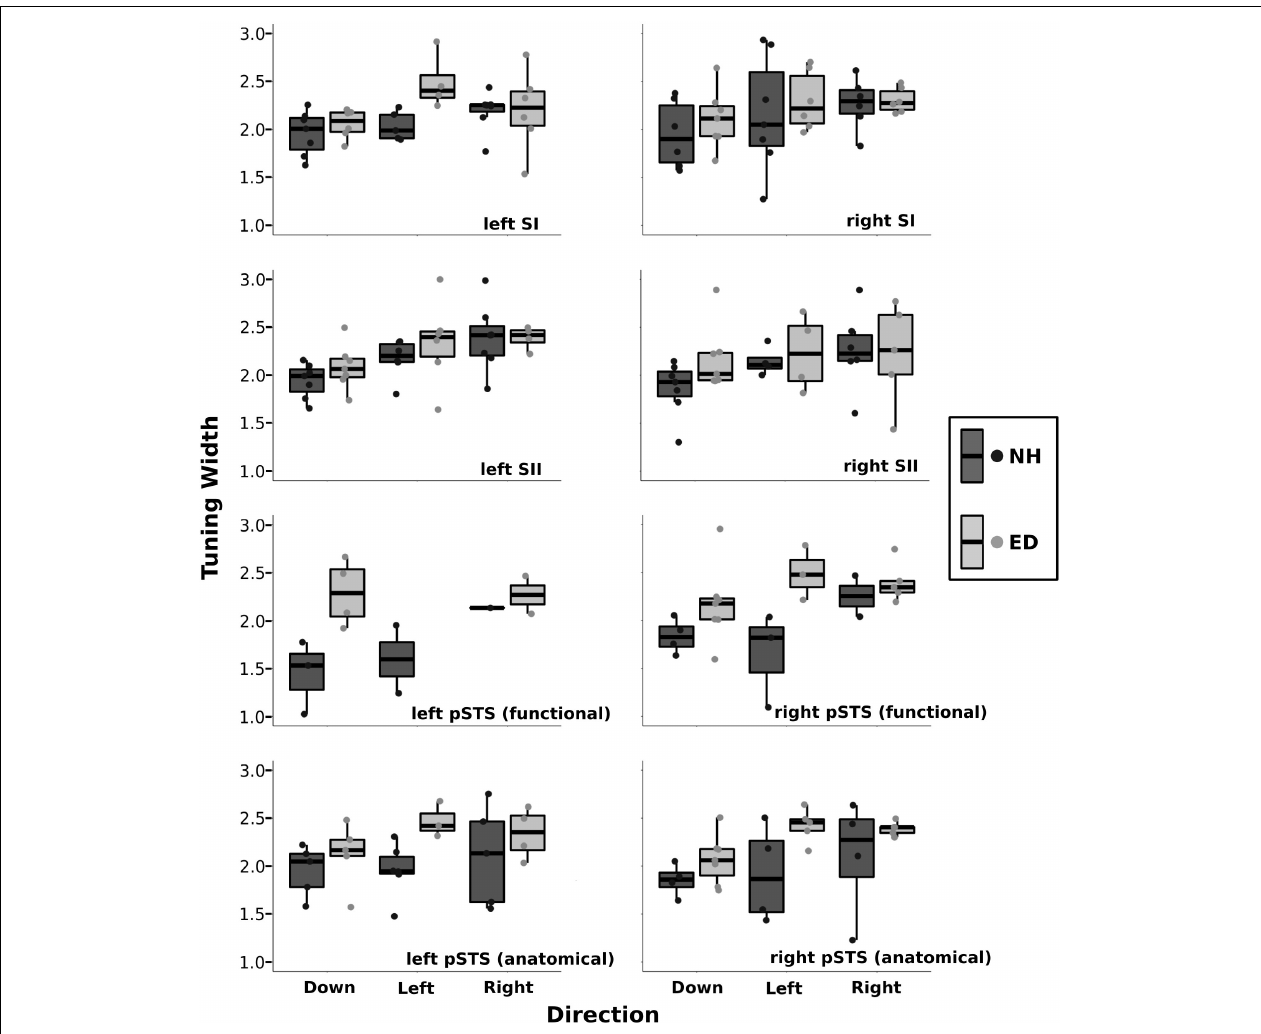
FIGURE 6 | Tuning width estimates are shown separately for down, left, and right directions within the primary and secondary somatosensory ROIs as well as for the functionally and anatomically defined pSTS regions. Boxplots are displayed for each group (NH: dark gray, ED: light gray) where the lower and upper hinges correspond to the 25th and 75th percentiles, and the central bar corresponds to the median. The upper and lower whiskers extend to the largest and smallest, respectively, value no further than 1.5 × the interquartile range. Individual data are also plotted for NH (dark gray circles) and ED (light gray circles).